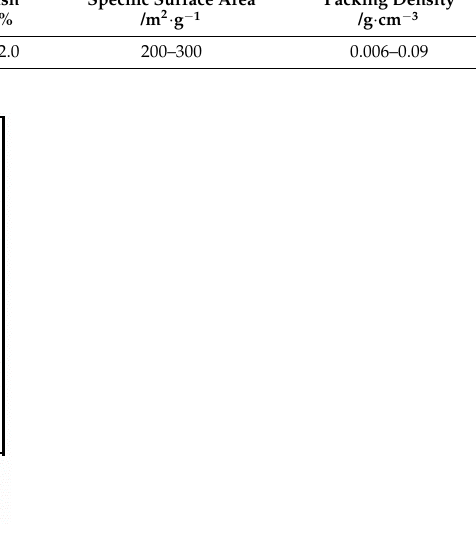
Figure 1. Granulometry curve of sand.